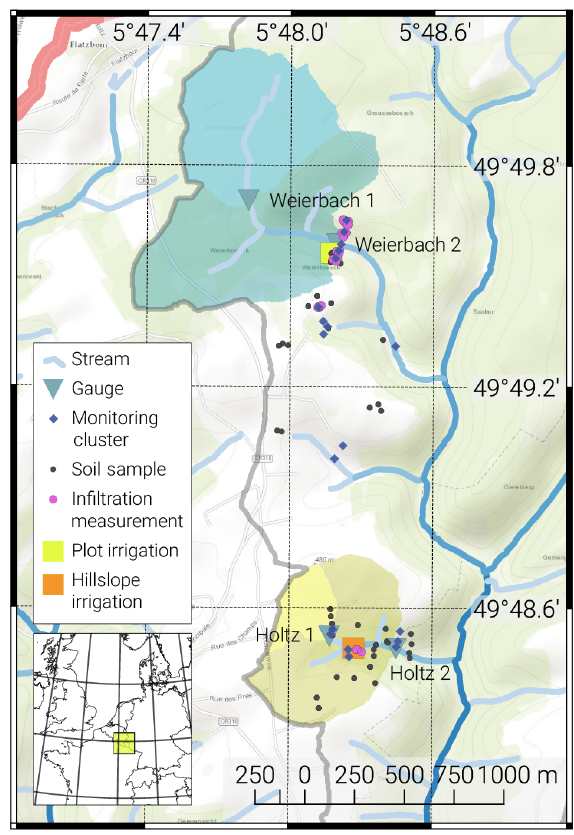
Figure 1. Map of the study sites in the upper Attert basin, Luxem-